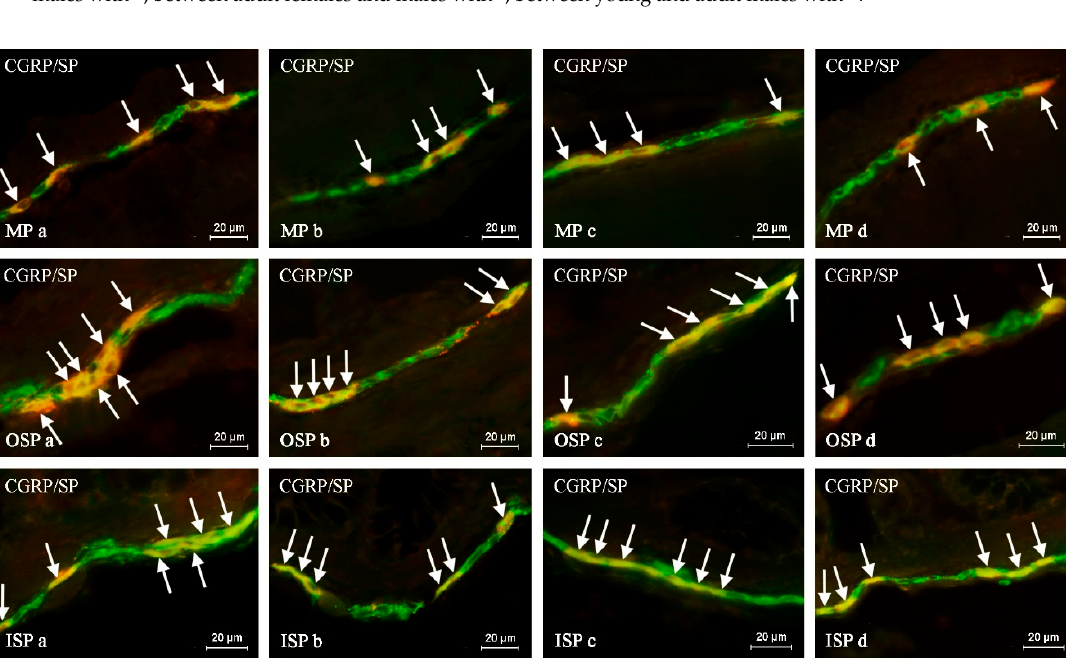
CML: circular muscle layer; MP: myenteric plexus; OSP: outer submucous plexus; ISP: inner submucous plexus; ML: mucosal layer; CB: cell bodies; NF: nerve fibers. 1 The average percentage of SP: positive nerve fibers with regard to all nerves immunoreactive to CGRP (mean ± SEM). 2 The relative frequency of SP: positive neurons presented as a percentage (mean ± SEM) of all neurons counted within the ganglia stained for CGRP. Statistically significant ( p ≤ 0.05) differences are marked as follows: between young and adult females with a , between young females and males with b , between adult females and males with c , between young and adult males with d . 2.3. Co-Localization of CGRP and VAChT Another substance showing a high degree of co-localization with CGRP within the enteric neuronal structures was VAChT—a marker of cholinergic neurons. In young animals of both genders, the degree of co-localization of CGRP and VAChT was similar for neurons located in the MP and ISP, as well as fibers placed in the muscular and mucosal layers (Table 3). Only the percentage of CGRP+/VAChT+ neurons in the OSP of young males was statistically significantly higher than in young females (Table 3).